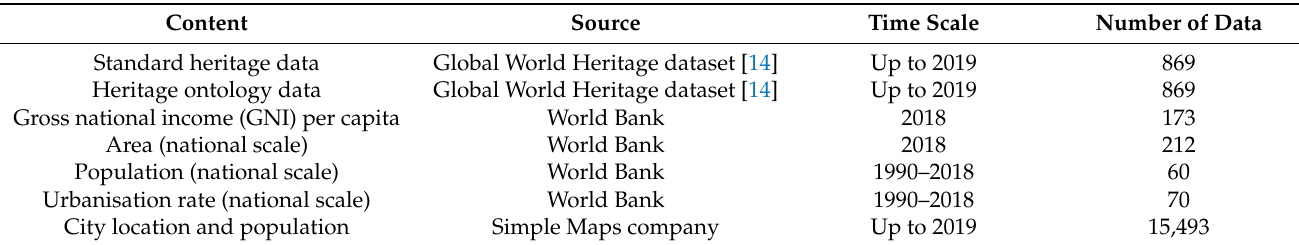
Table 1. Data source and coverage introduction